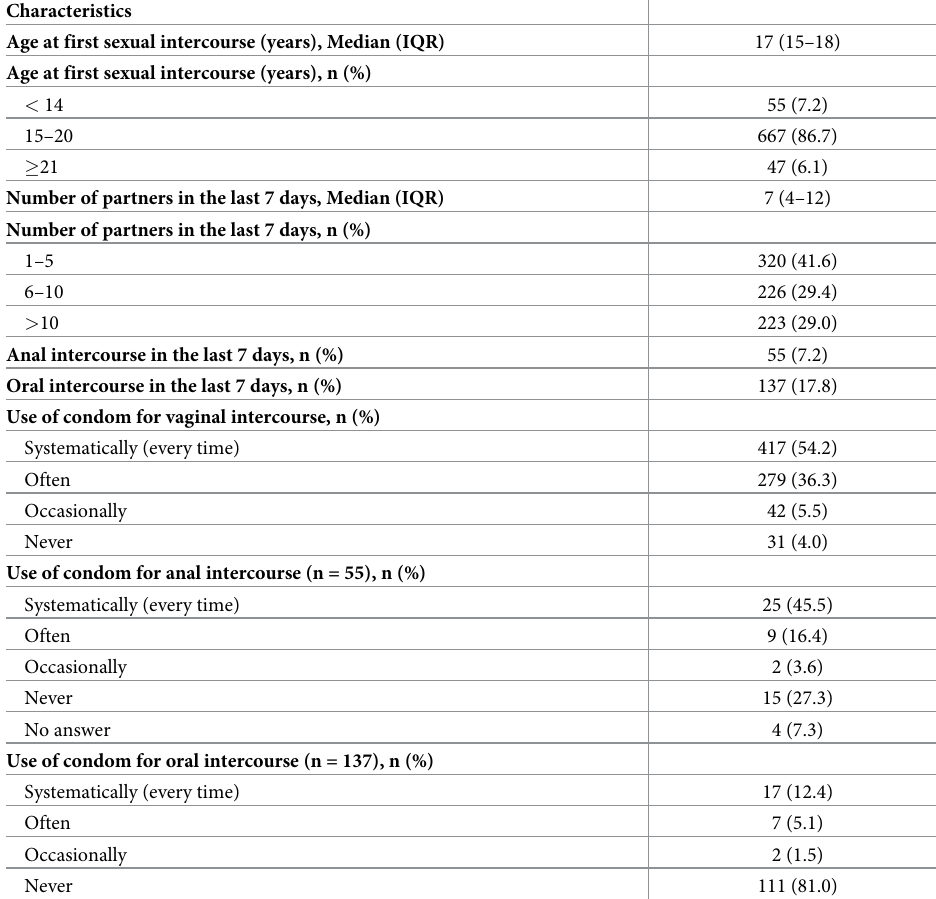
Table 2. Sexual practices among female sex workers in Togo in 2017 (N = 769).